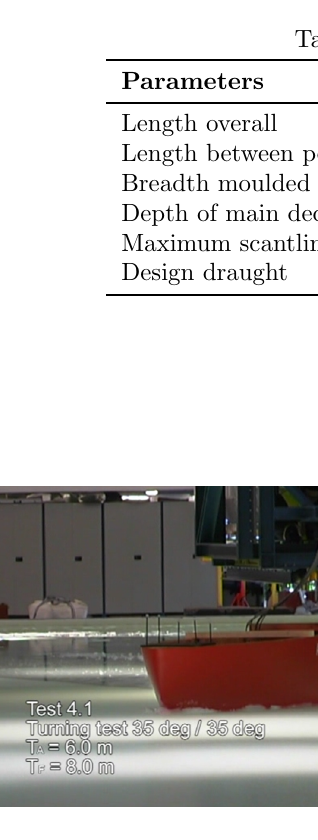
Figure 2: An example of the maneuvering tests in level ice (Source: Aker Arctic model test, Leivisk¨a (2011))